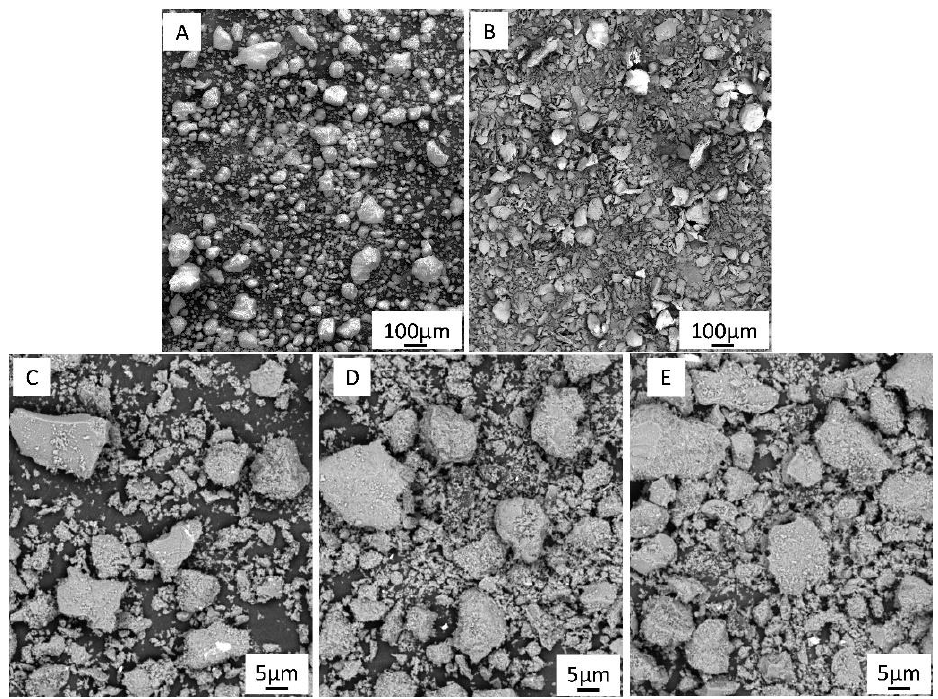
Figure 2. SEM micrographs of raw alumina ( A ), PLA ( B ) and ceramic-polymer mixtures with 50 ( C ), 60 ( D ) and 70 ( E ) vol.% of Al 2 O 3 .